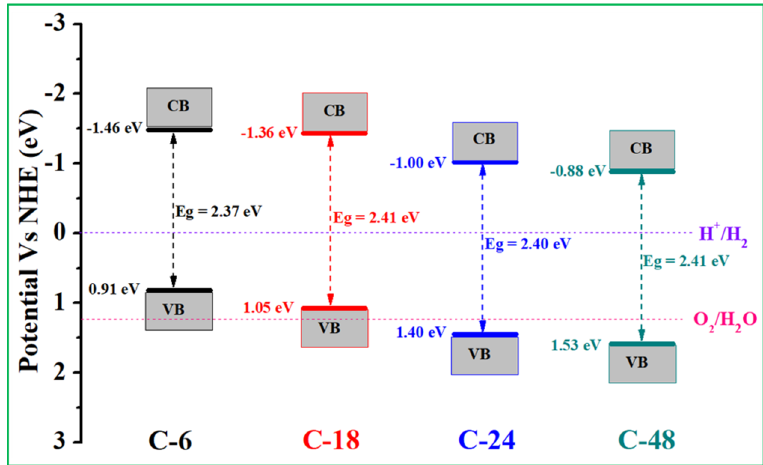
Figure 9. Relative arrangement of valence band (VB) and conduction band (CB) positions for CdS NR samples.